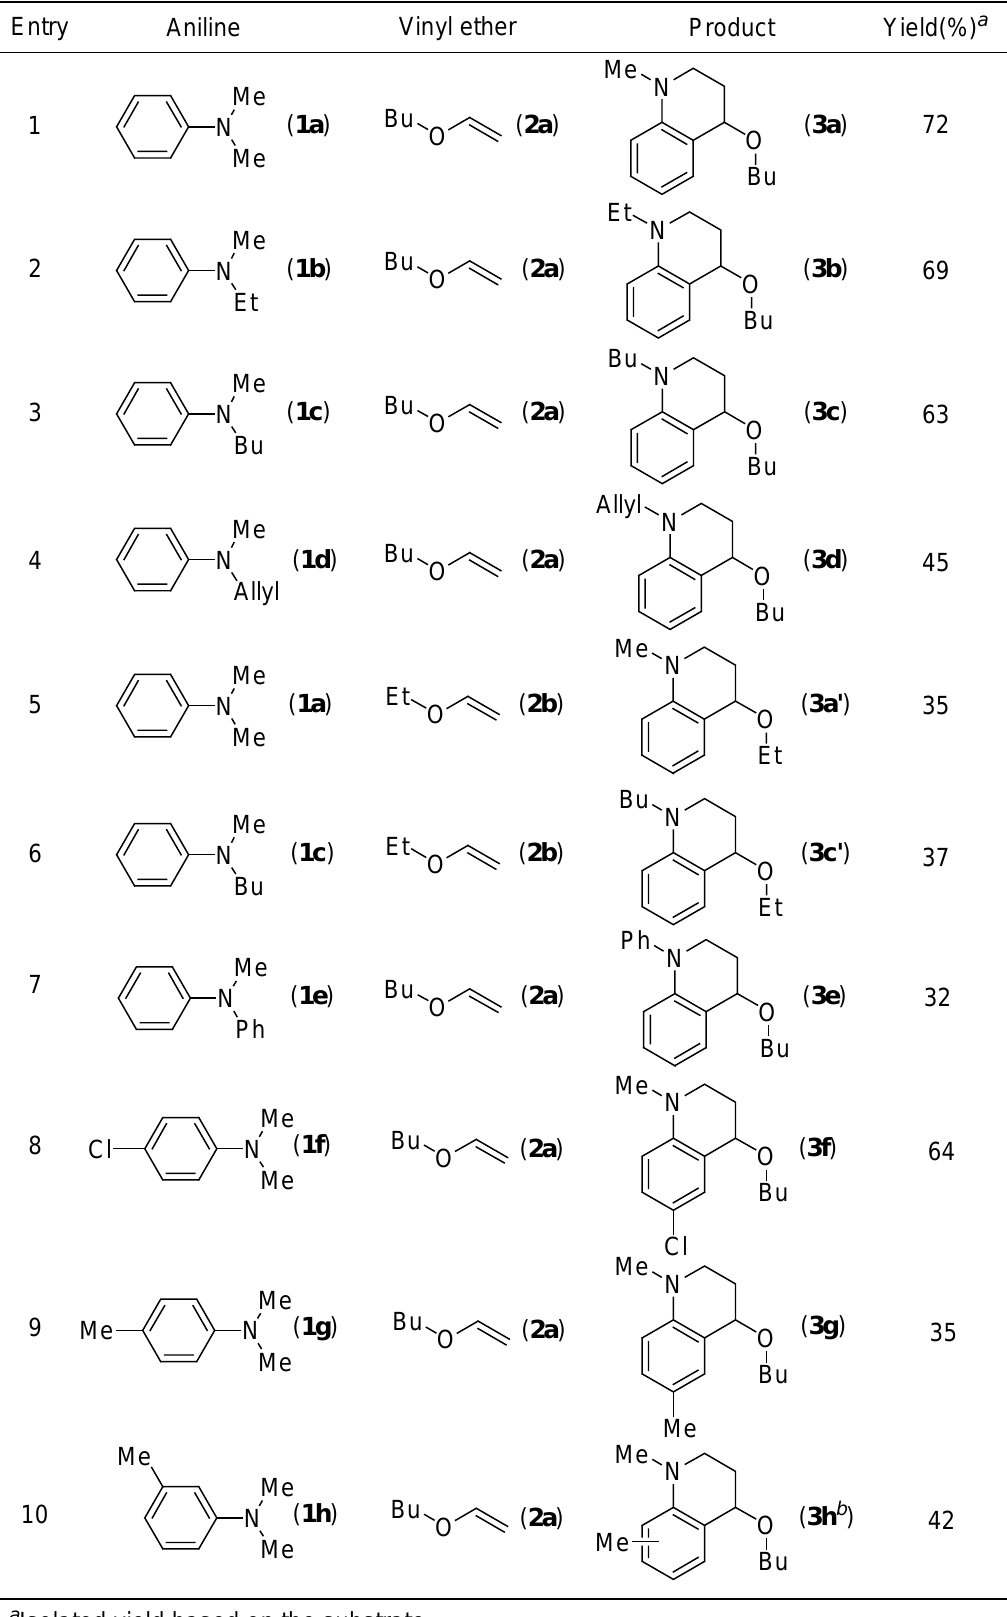
Table 2 . Reaction of N -methyl- N -alkylanilines with vinyl ether catalyzed by CuCl